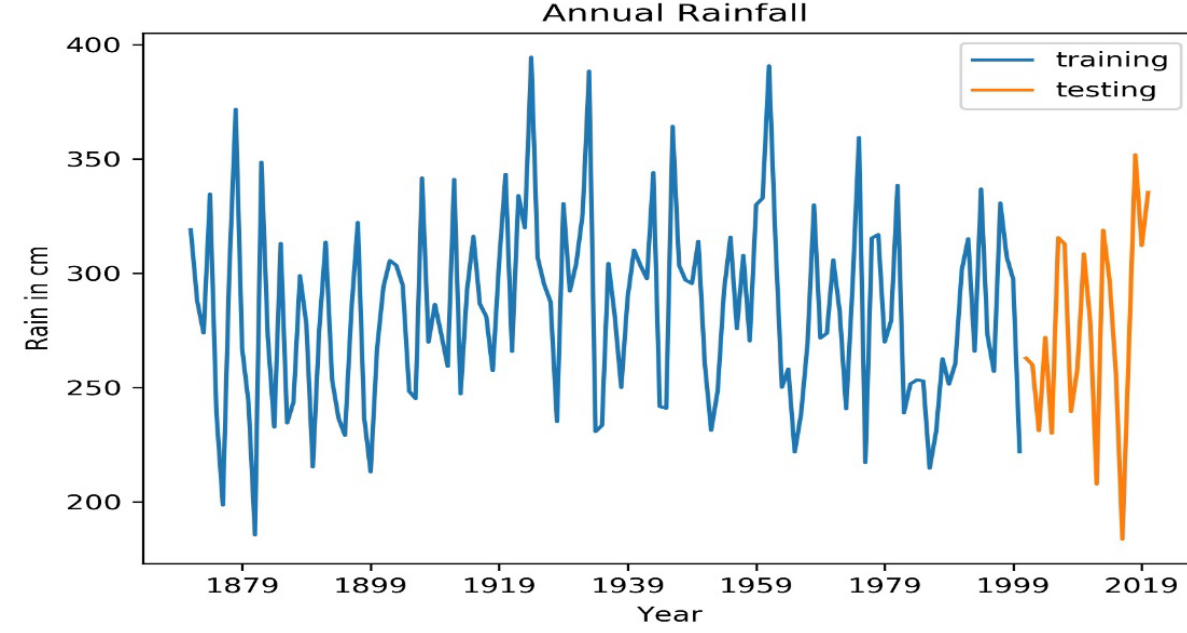
Figure 4. Annual rainfall divided into training and testing datasets.